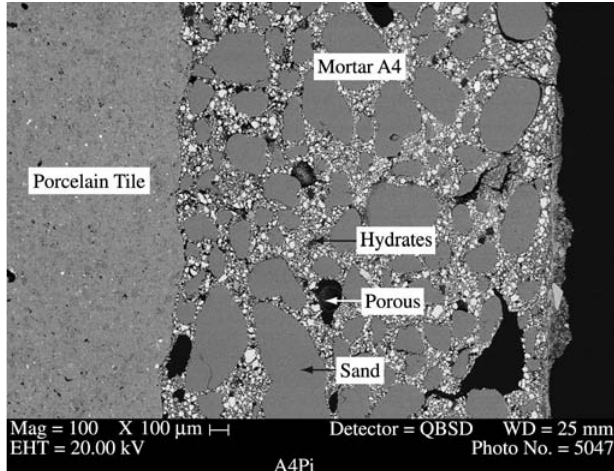
Figure 6. Backscattered electron micrograph of the polished surface. showing the interface between porcelain tile and mortar containing 5% silica fume and 20%